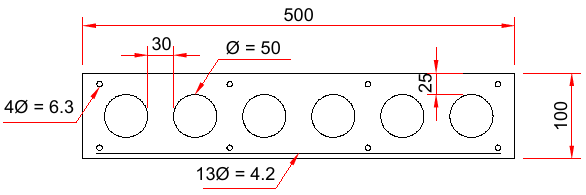
Figure 2 – Geometrical properties of hollow-core slabs. ( Note: units in mm